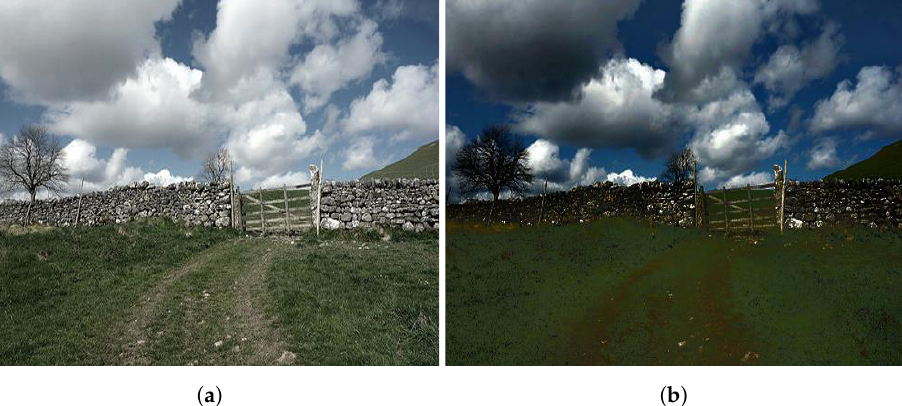
Figure 1. Visibility reduction when invoking image dehazing on a haze-free image. ( a ) Haze-free image and ( b ) its corresponding dehazed